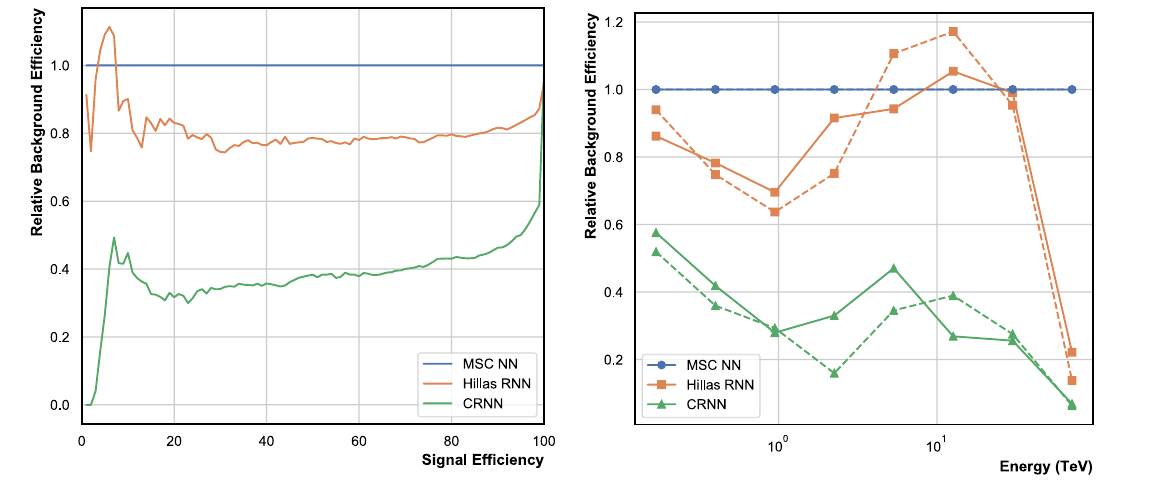
performance) for the two recurrent networks at 80% (solid line) and 60% signal efficiency. Events are re-weighted to represent an energy spectrum of E − 2 for both signal and